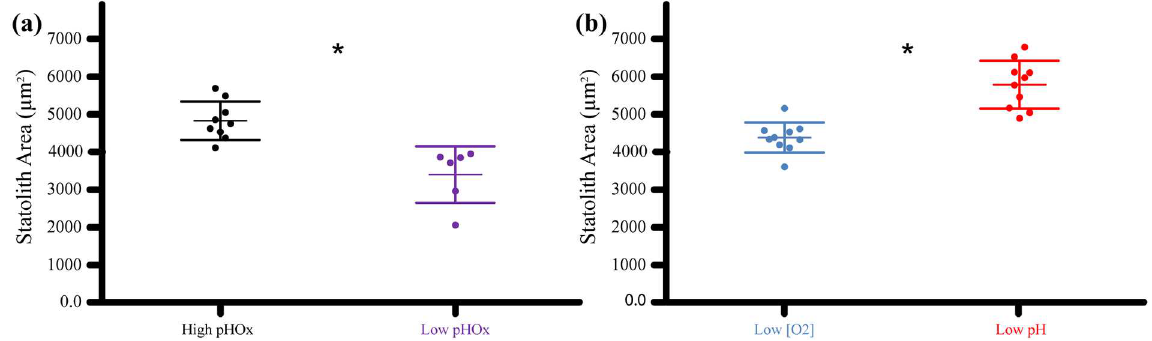
Fig 9. Embryonic statolith area ( μ m 2 ) by treatment. Y-axis = averagestatolith area per capsule.Each capsule = Average of five statoliths. (a) Experiment 1. X-axis = treatment. All statoliths are from embryosat stage 28 in Cohort 1. * = treatment effect ( p = 0 . 0014 ).(b) Experiment 2. X-axis = treatment. All statoliths are from embryos at stage 29. ** = treatment effect ( p < 0 . 0001 ). Bars = ± 1 standard